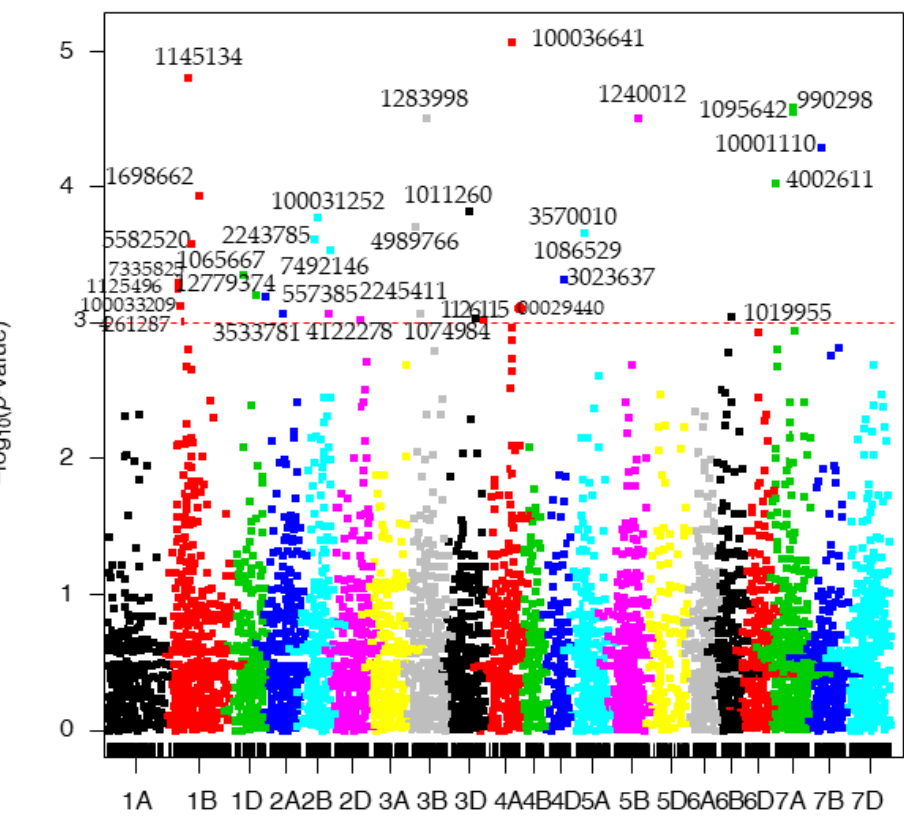
Figure 3. Manhattan plots for spot blotch disease (SB) corresponding to the consensus map. The p -values are shown on a log 10 scale. The marker is considered significant if log 10 scale is 3 or